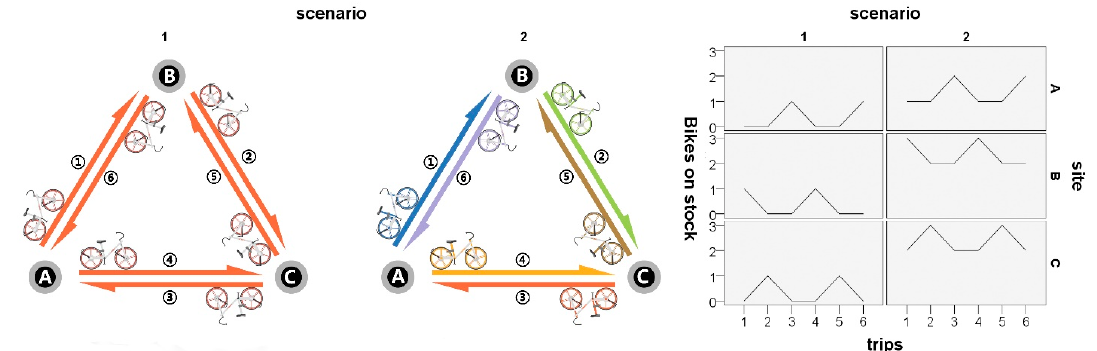
Figure 1. Bike movement and stocks in different scenarios: (1) only one bike at site A and (2) two bikes at each site.